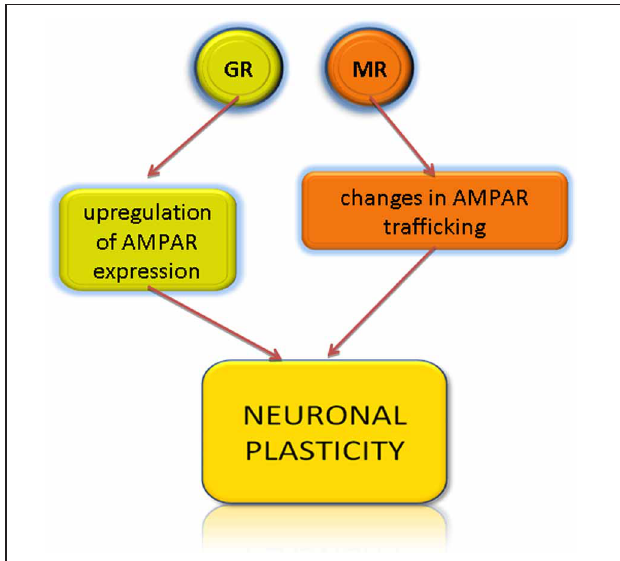
FIGURE 4 | Glucocorticoids induce neuronal plasticity via respective receptors. AMPAR, α -amino-3-hydroxy-5-methyl-4-isoxazolepropionic acid receptor; GR, glucocorticoid receptor; MR, mineralcorticoid